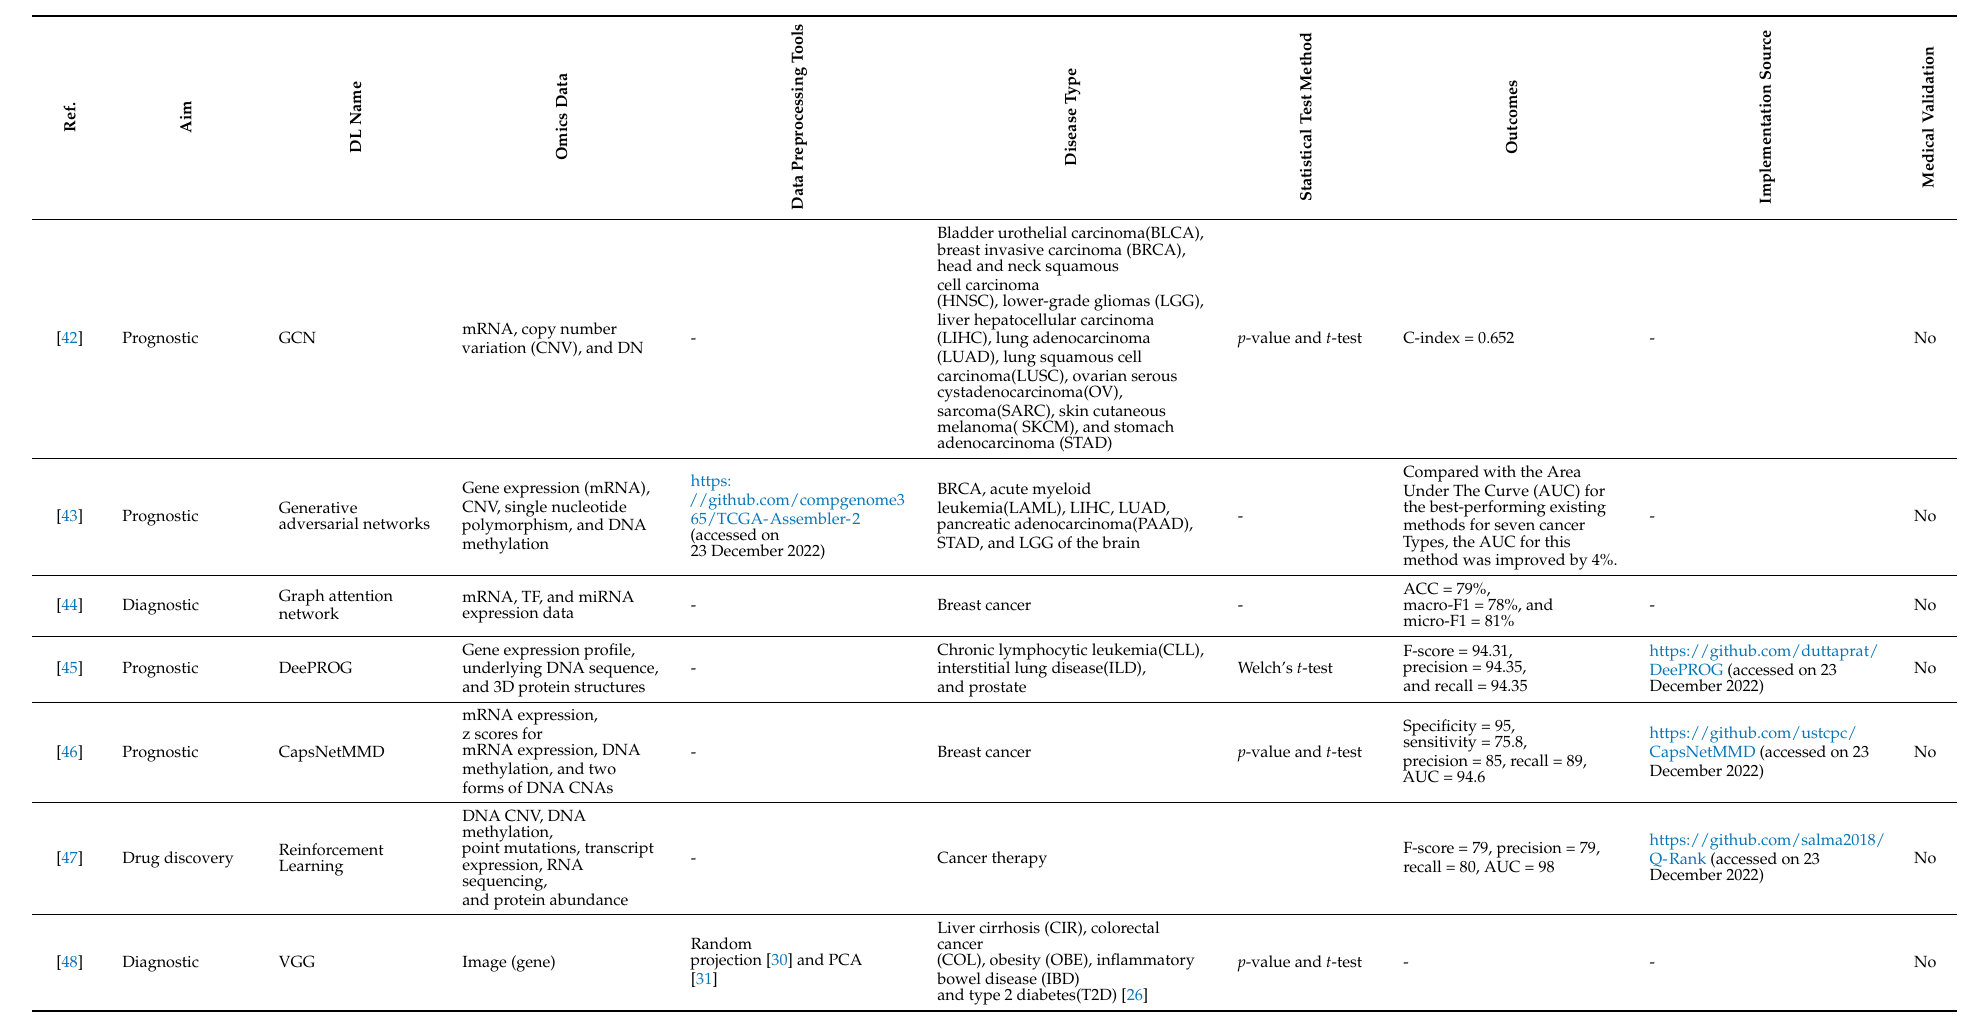
Table 2. Biomarker discovery